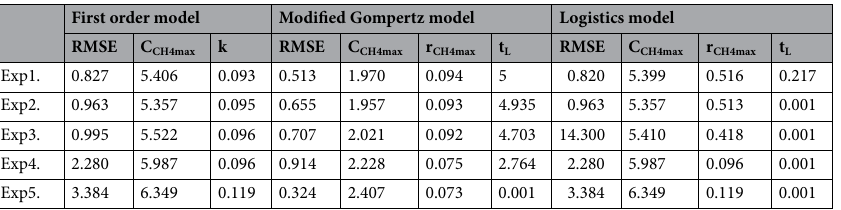
Table 3. Results of kinetic study using three different